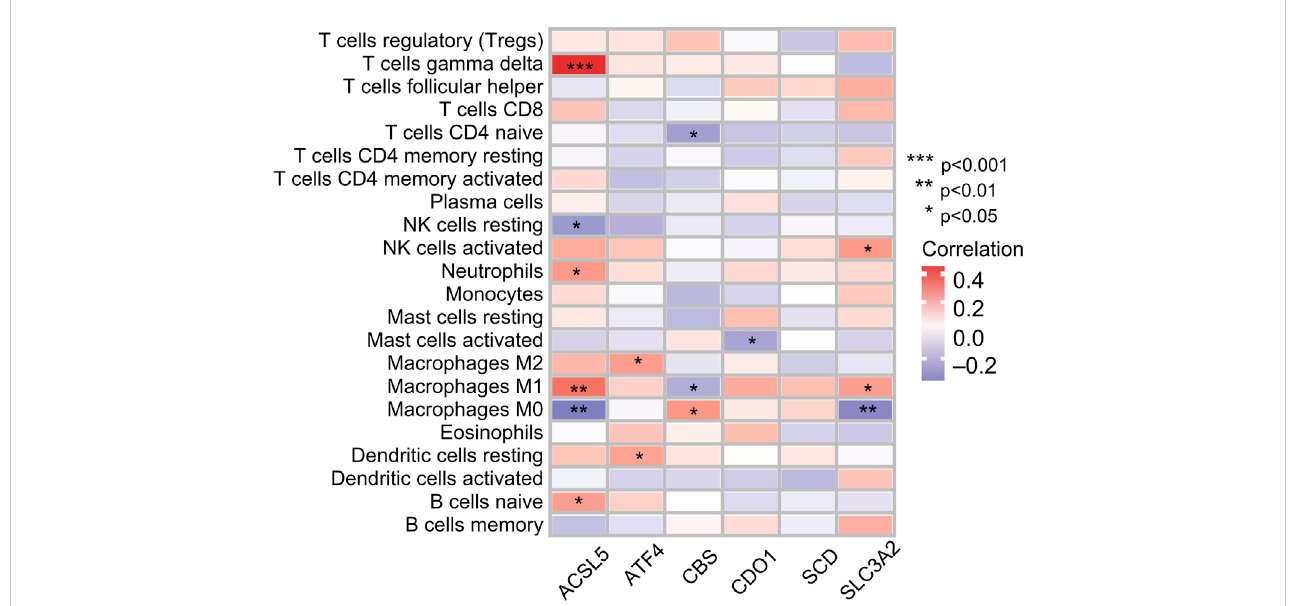
FIGURE 8 Correlation between immune cell ratios based on CIBERSORT algorithm and expression levels of six genes used for risk score model construction.